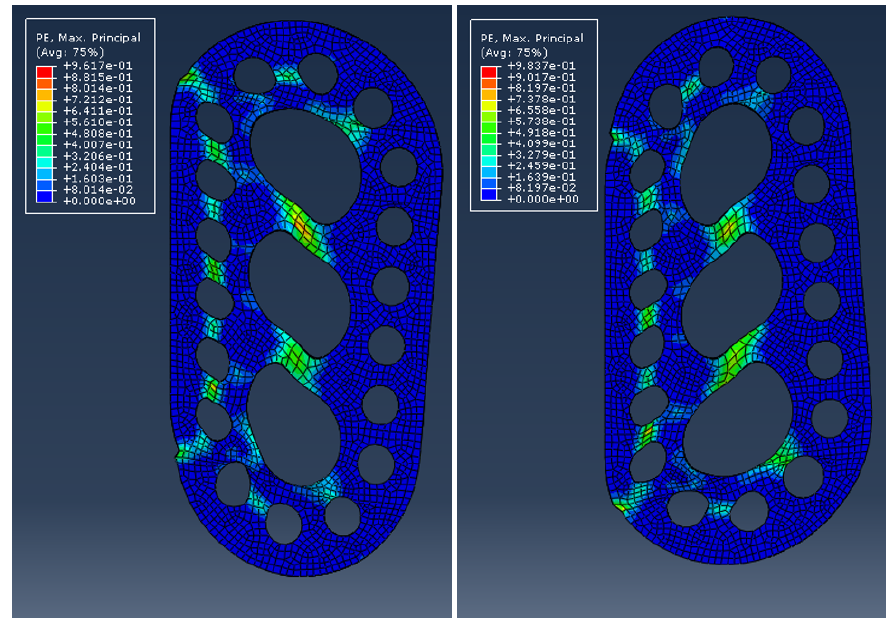
Figure 9. Maximum principal plastic strains for upward 2.5 in (64 mm) displacement ( right ) and downward 2.5 in (64 mm) displacement ( left ) for the MYZ shape.